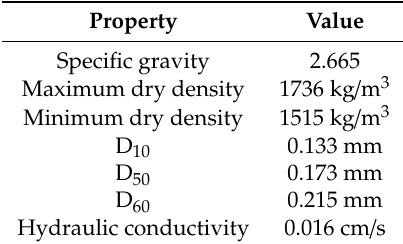
Table 5. Index parameter of Ottawa F-65 Sand (Parra et al. (2017) [35]).